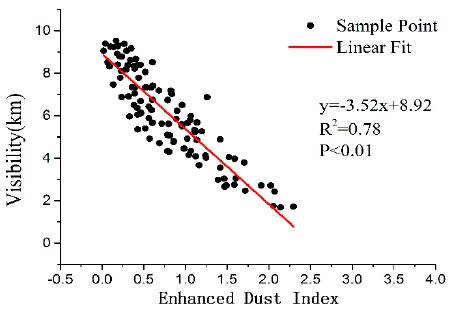
Figure 8. The relationship of satellite-retrieved Enhanced Dust Index and in-situ visibility.